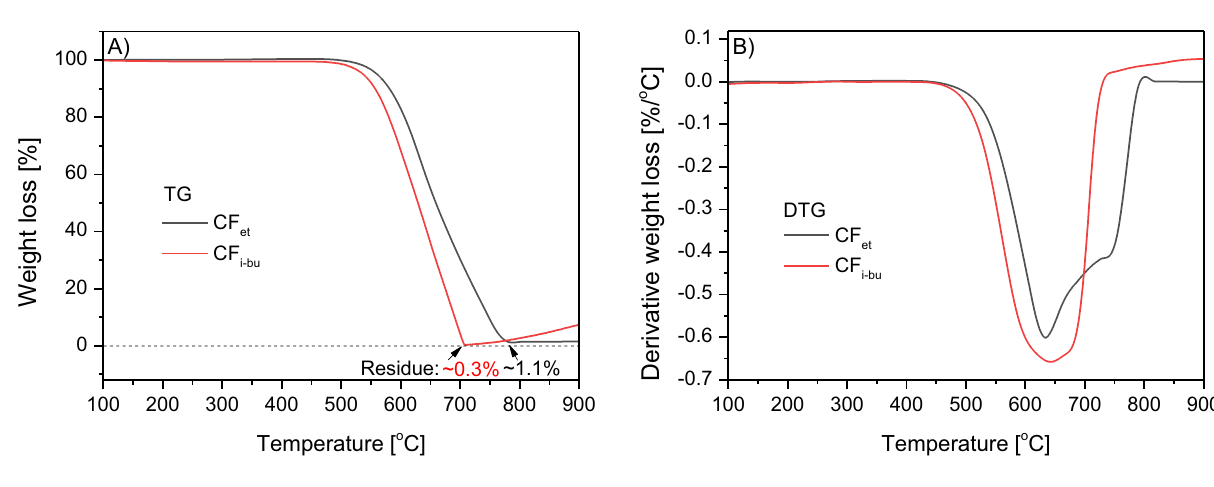
Figure 5. TG ( A ) and DTG ( B ) curves of the CF et and CF i-bu samples (air